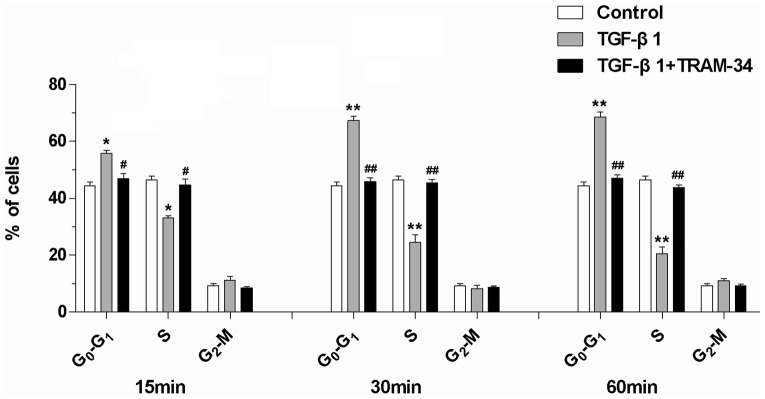
Changes in cell cycle progression at three time points under induction of TGF-β1 and TGF-β1+TRAM-34 (* P<0.05 and ** P<0.01versus control; # P<0.05 and ## P<0.01 versus the TGF-β1-induced; n = 5).